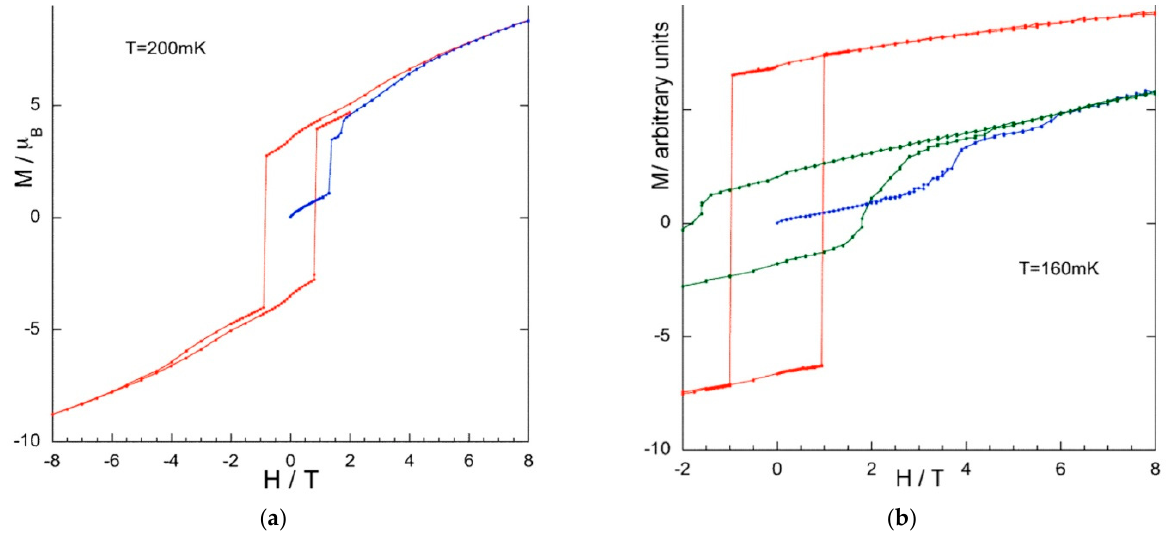
Figure 9. ( a ) Hysteresis measured on a powder sample of 11 at 200 mK; blue data points represent the initial magnetization [44]; ( b ) Hysteresis loops collected at 160 mK on a single crystal of 11 along the b axis (red) and c axis (green) and the initial magnetization along the b axis (blue) [44]. Reproduced with permission from ref. [44]. © 2022 American Chemical Society.